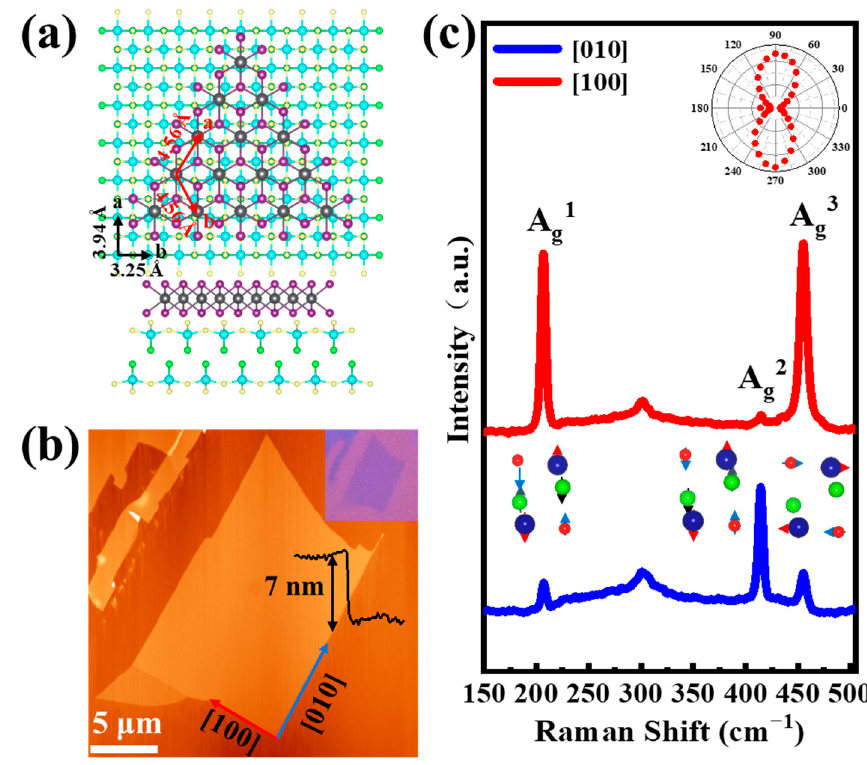
Figure 1. Characterization of thin − layered CrOCl nanoflake. ( a ) Atom structure of PbI 2 /CrOCl heterostructure; ( b ) AFM image of layered CrOCl nanoflake with the thickness and crystal orientation highlighted. The corresponding OM image is inserted at the right top corner; ( c ) Raman spectra of CrOCl nanoflake along the [010] direction and [100] direction, respectively. There is a strong in − plane anisotropy of the 𝐴 (cid:3034) mode intensity. The atomic vibrations of 𝐴 (cid:3034)(cid:2869) , 𝐴 (cid:3034)(cid:2870) , and 𝐴 (cid:3034)(cid:2871) modes, and the polar plot of 𝐴 (cid:3034)(cid:2869) mode is inserted.